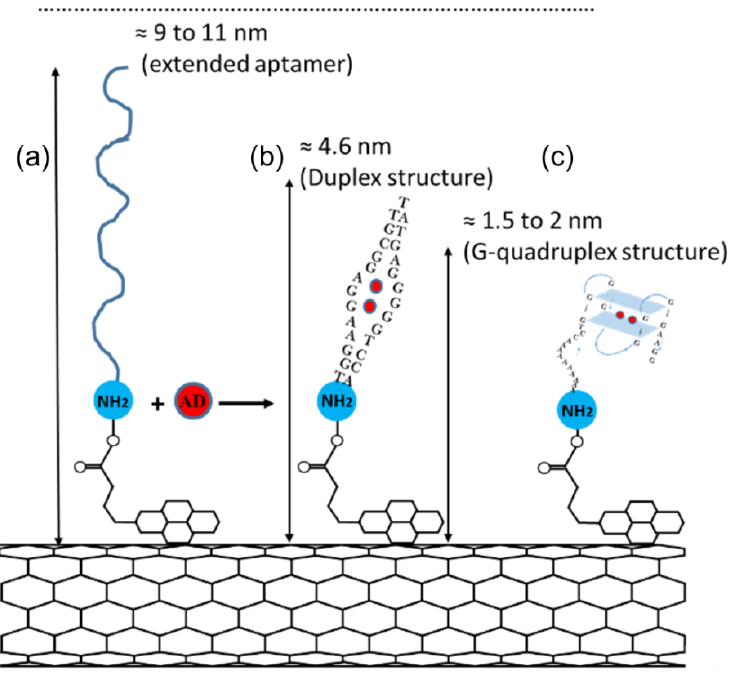
Figure 5. Schematic representation of ( a ) fully extended adenosine aptamers immobilized onto the surface of a CNT via PBASE linker and ( b ) the formation of Duplex and ( c ) G-quadruplex structure by 27-mer and 35-mer aptamers, respectively, after adenosine molecule binding (not to scale).